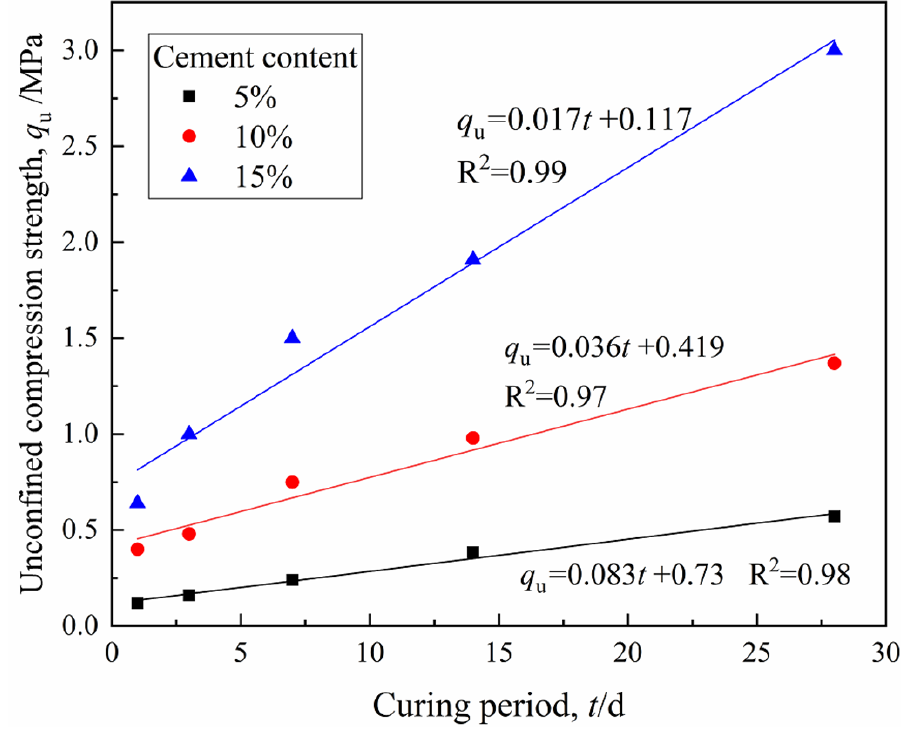
Figure 12. Unconfined compressive strength development versus curing period.